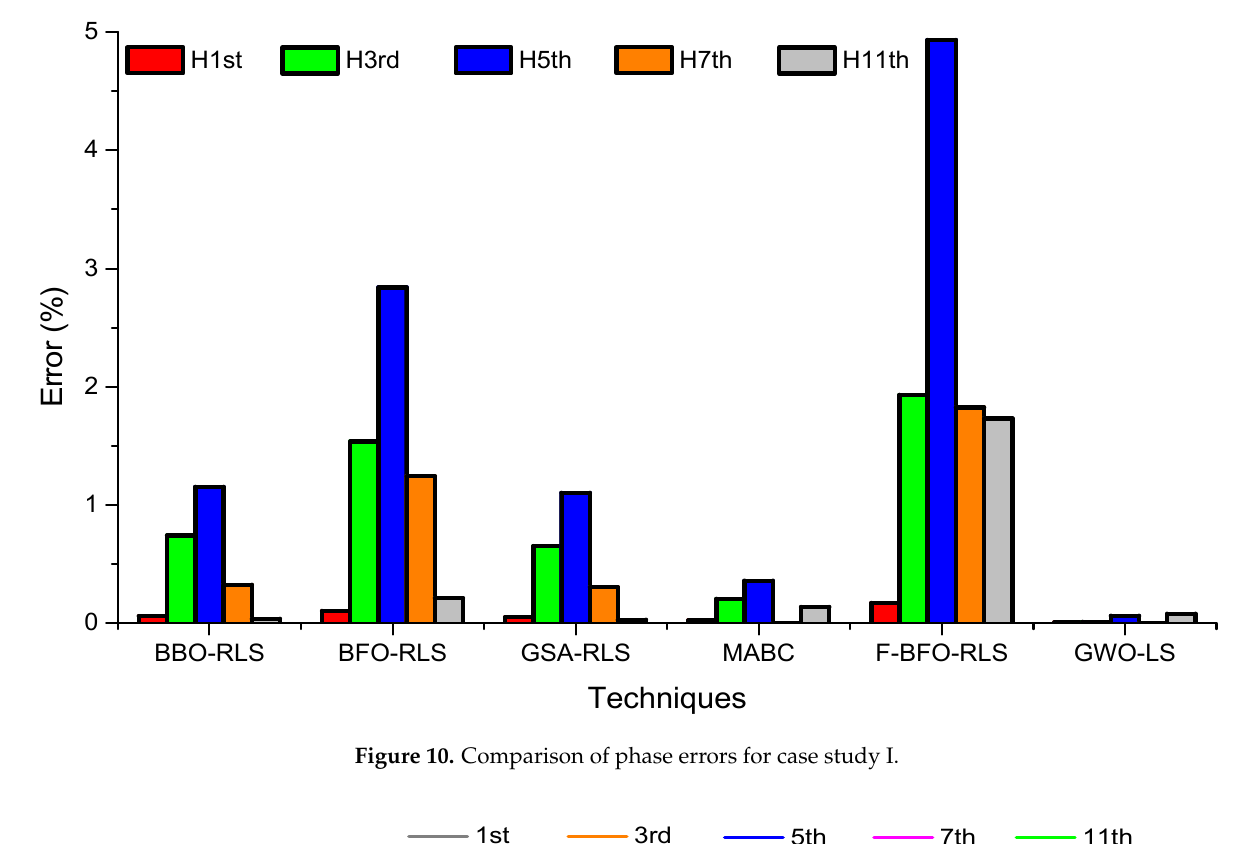
Figure 9. Comparison of amplitudes error for case study I.